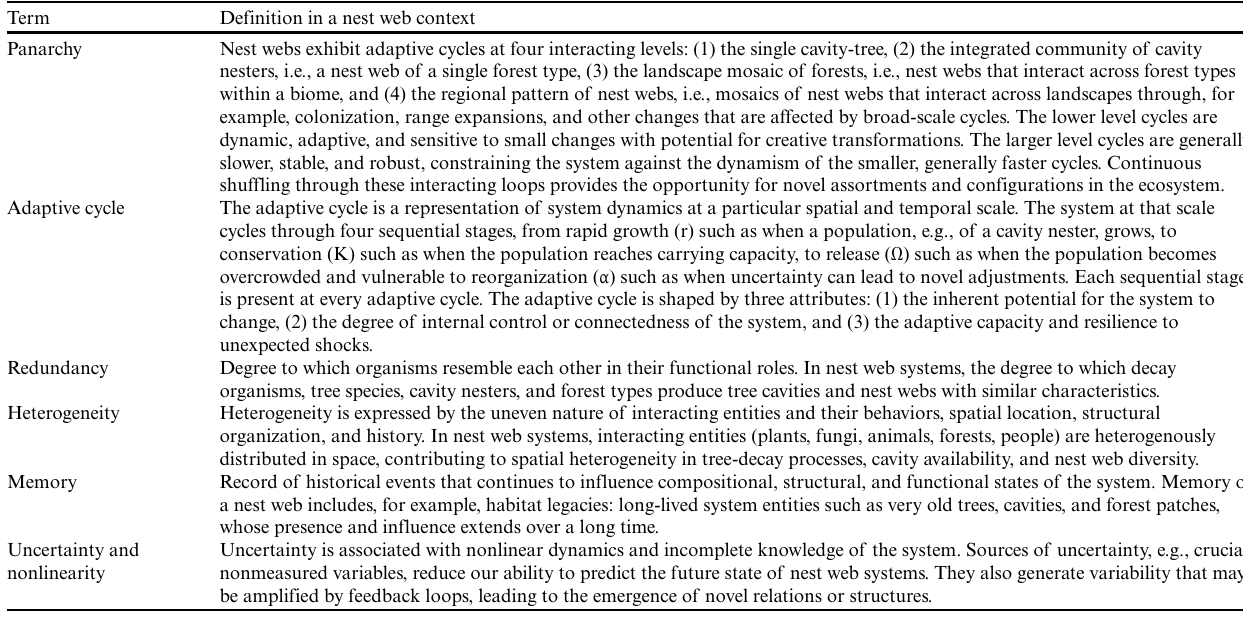
Table 1 . Panarchy, adaptive cycles, and properties of nest webs as complex adaptive systems (CAS).